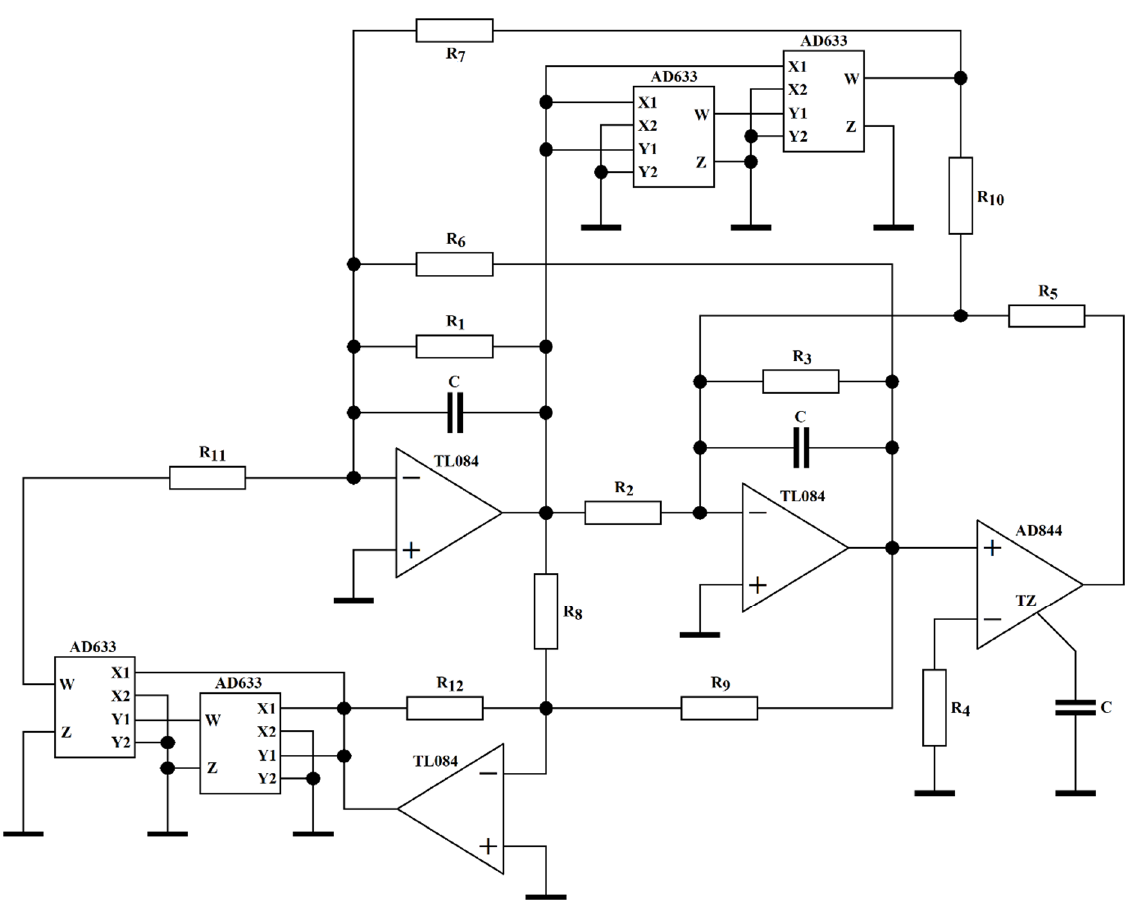
Figure 15. Third order autonomous analog chaotic oscillator using cheap and off-the-shelf active elements, namely single TL084, one AD844 and four AD633.